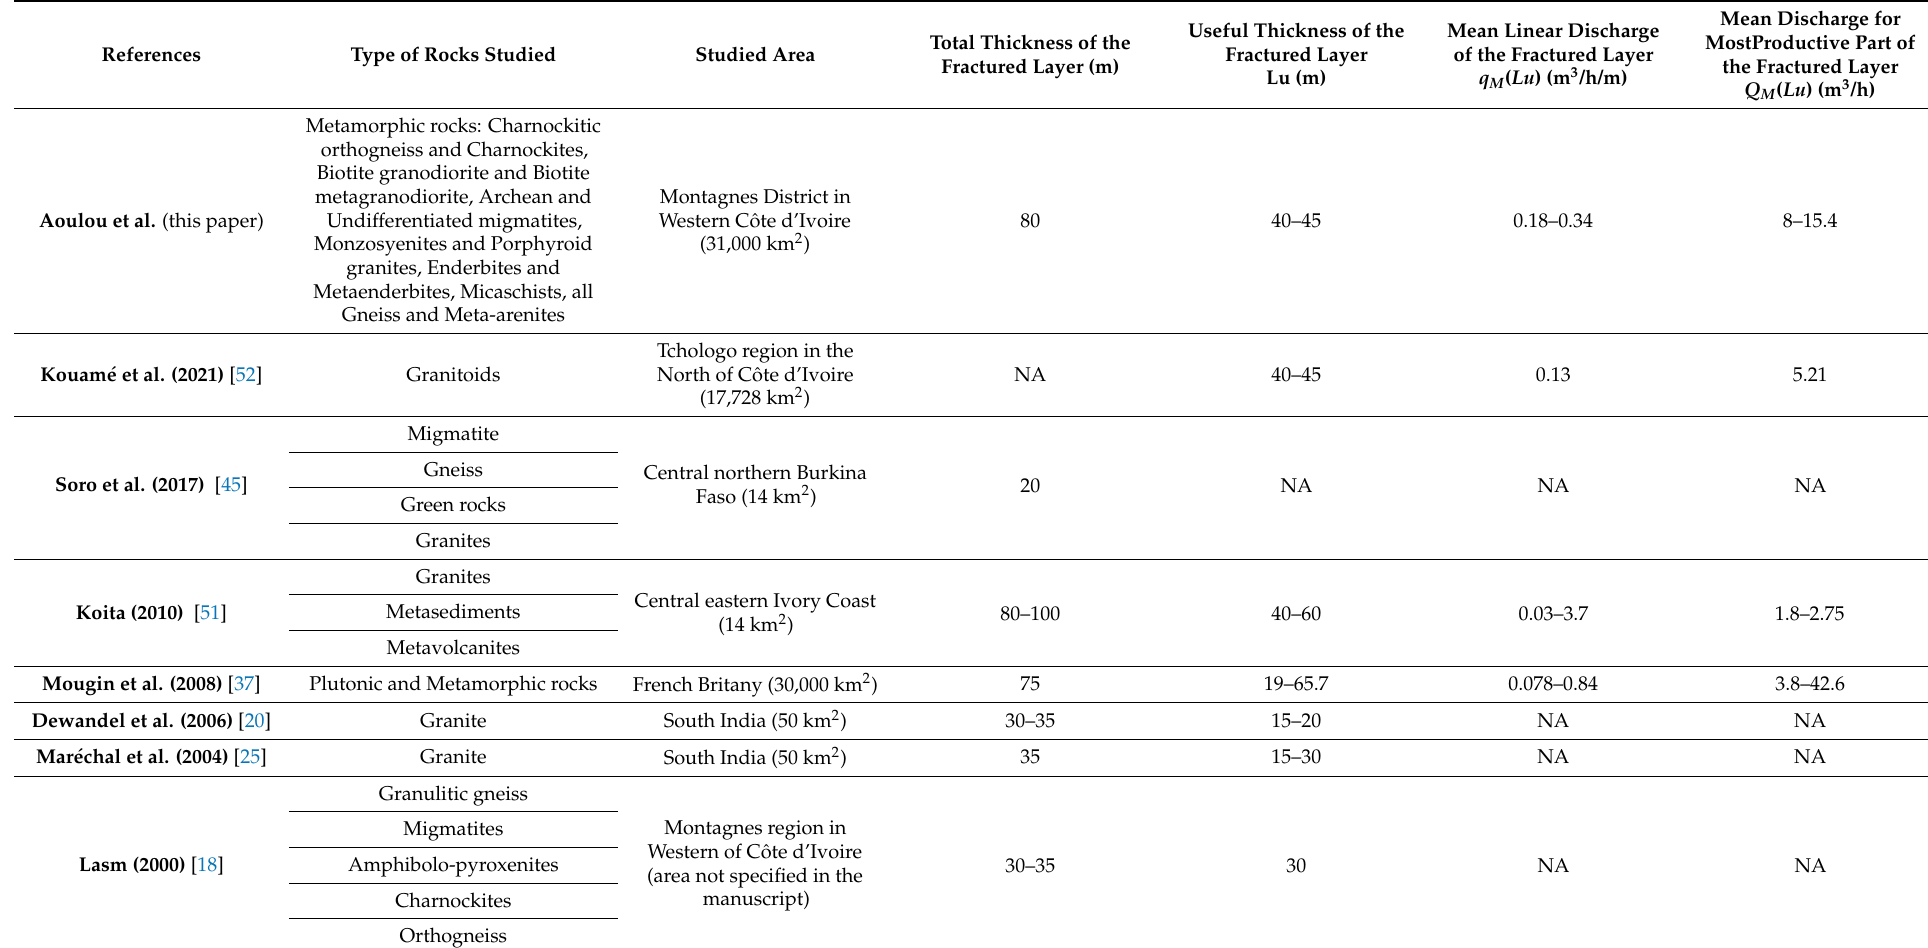
Table 9. Geometric and linear discharge (thickness or depth range) of basement aquifers. NA: no